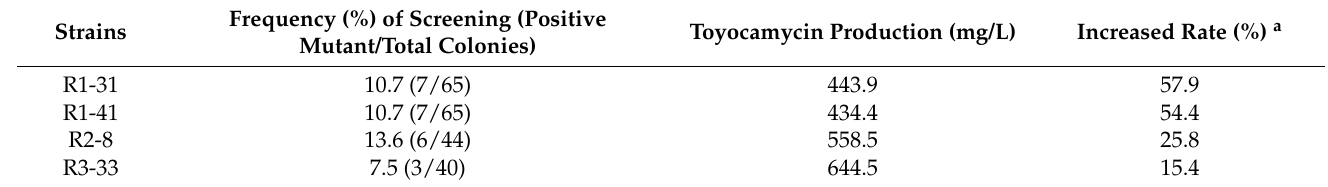
Table 2. The screening and toyocamycin production of drug-resistant mutants. Frequency (%) of Screening (Positive Strains Mutant/Total Colonies)